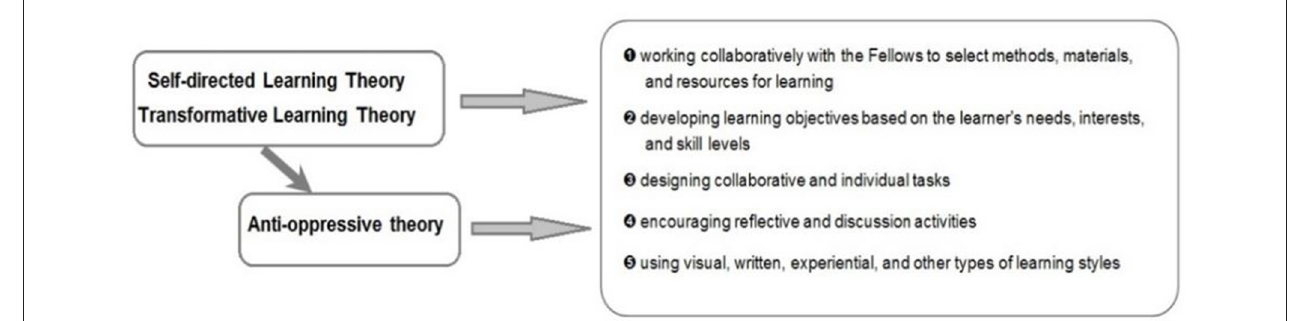
FIGURE 2 | Learning